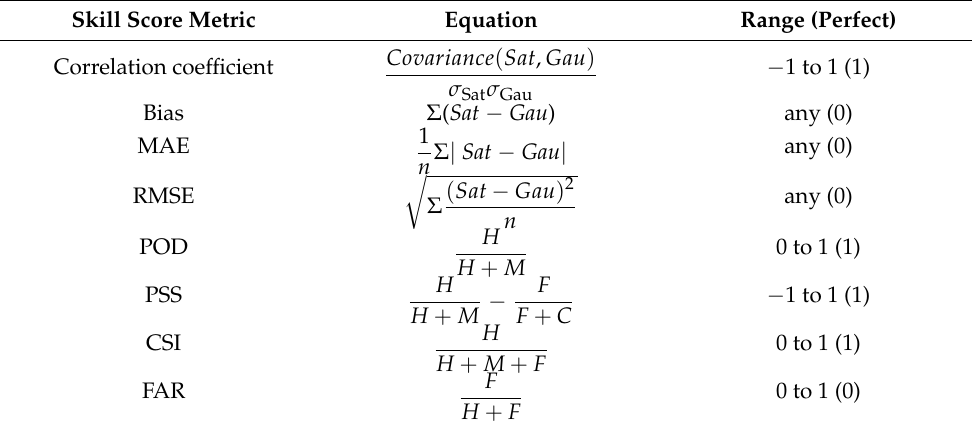
Table 2. Statistical skill metrics.